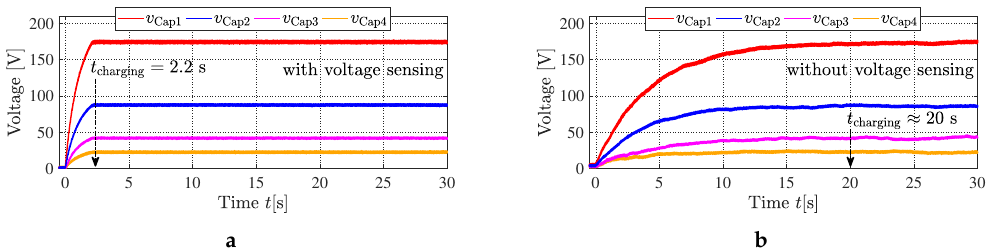
Figure 8. Measured charging of H-bridges’ capacitors during converter startup using addi- tional charging resistance R charging = 80 Ω ( a ), with sensing and ( b ) without sensing of the capacitor